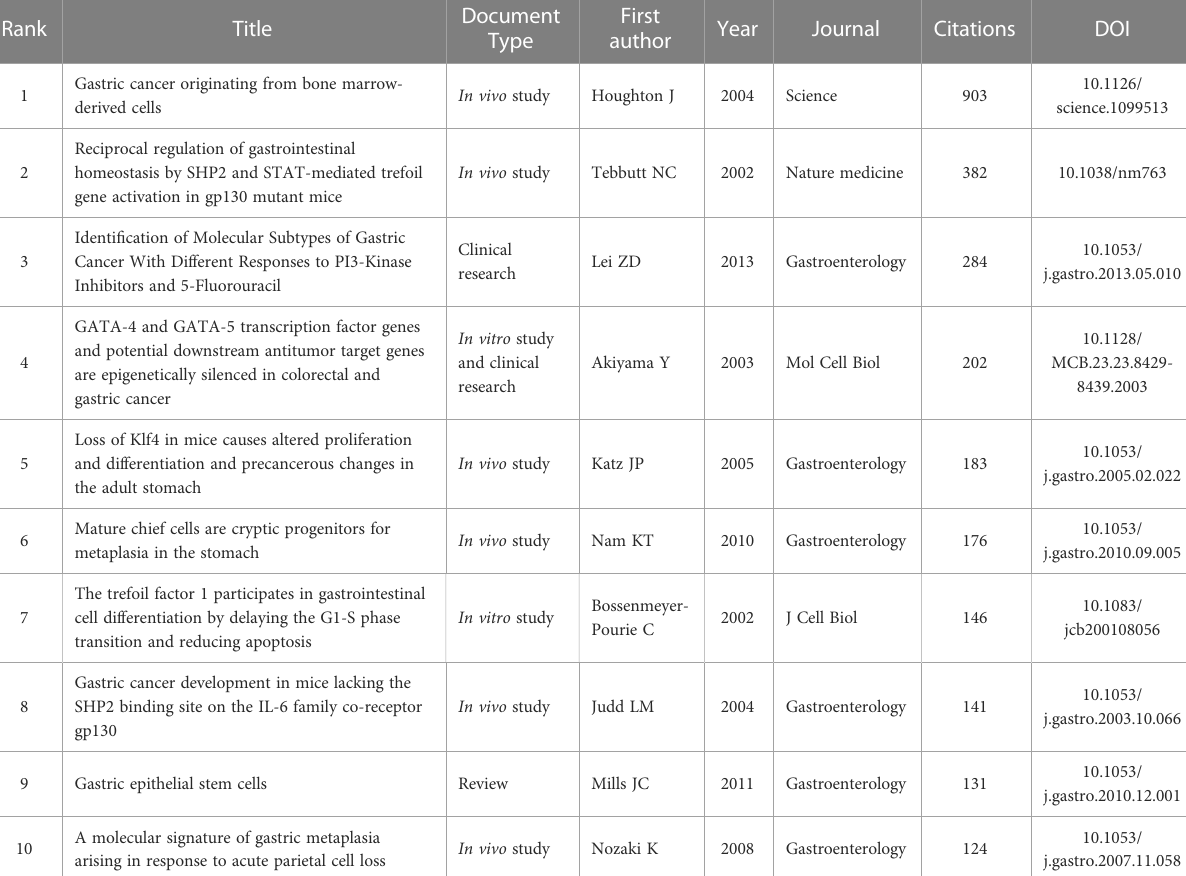
TABLE 6 The top 10 globally cited documents based on total citations in SPEM-GC research.